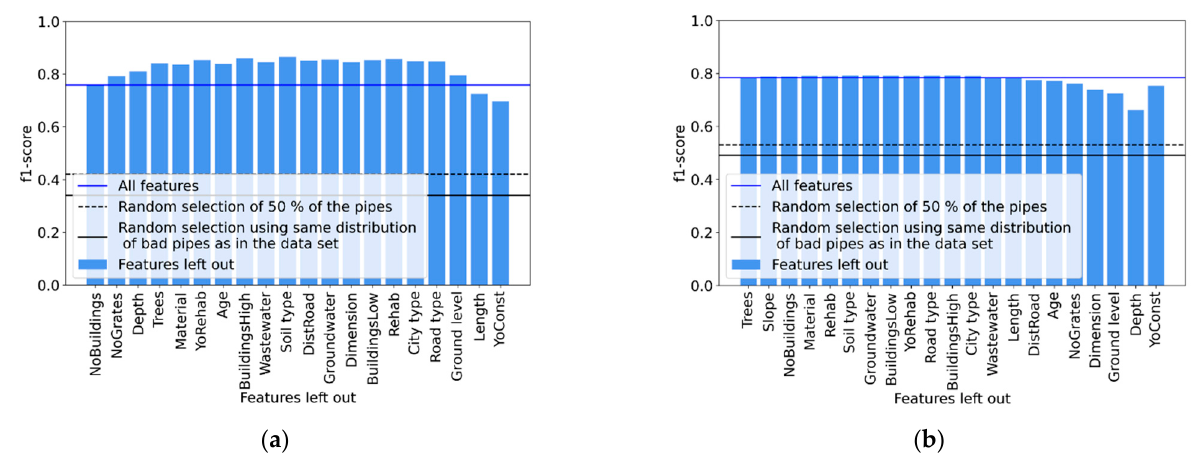
Figure 5. Feature analysis for ( a ) the utility with the lowest number of bad pipes (utility 10), ( b ) the utility with the highest number of bad pipes (utility 14).